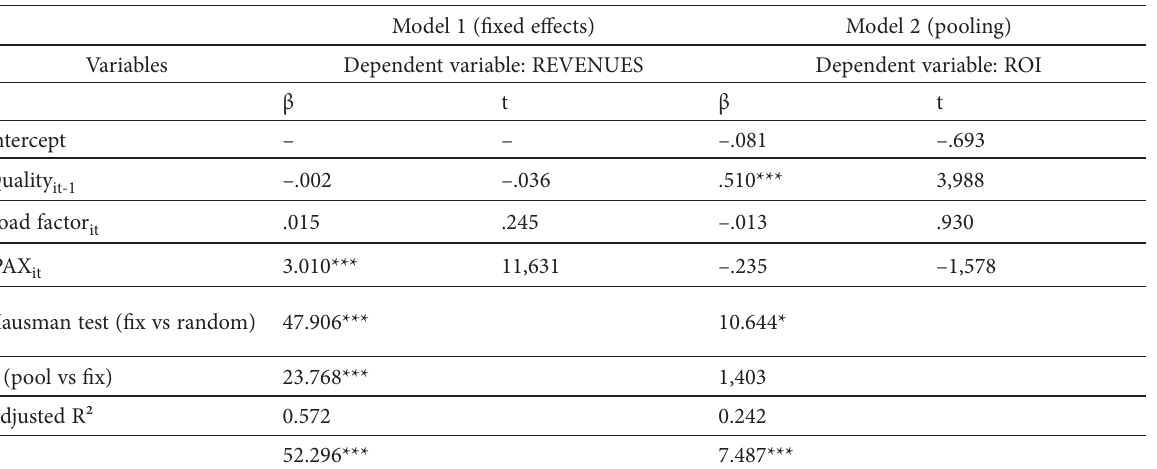
Table 5. Estimation models: robustness